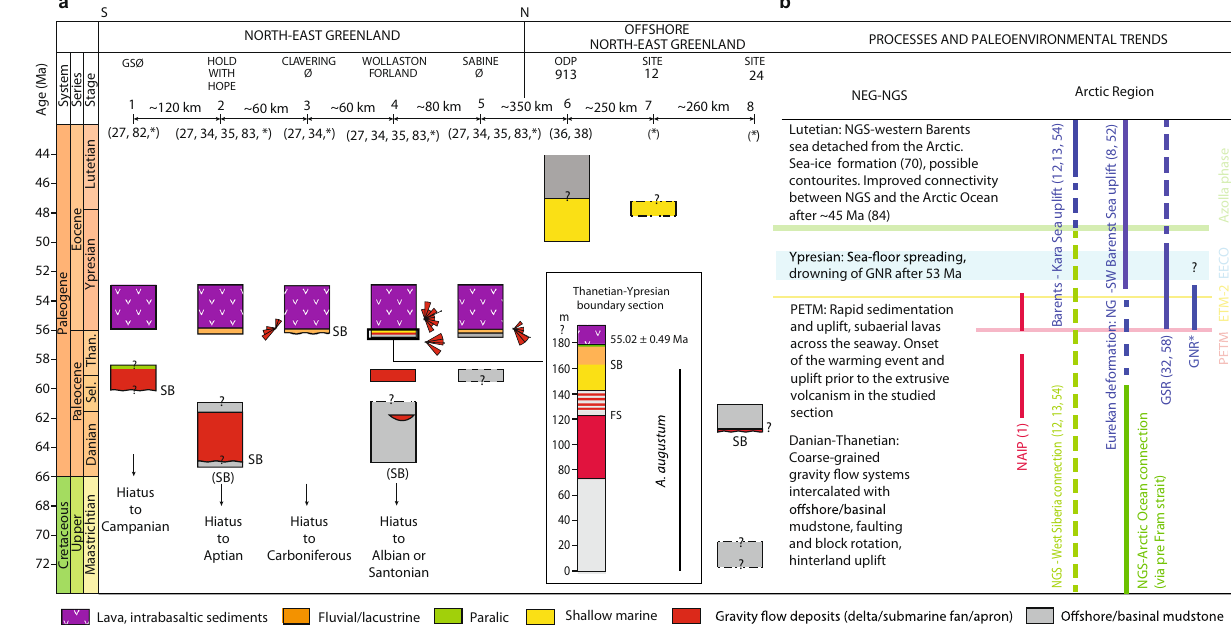
NEG-NGS Lutetian: NGS-western Barents sea detached from the Arctic. Sea-ice formation (70), possible contourites. Improved connectivity between NGS and the Arctic Ocean after ~45 Ma (84)